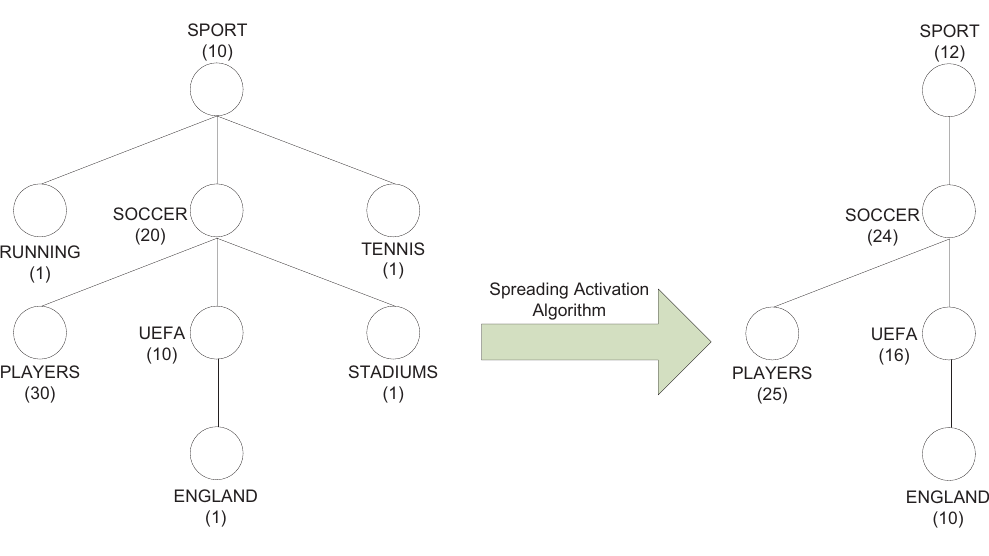
Figure 2. Schema of a small part of an ontological user profile where the scores to the concepts are updated after a user’s search (see